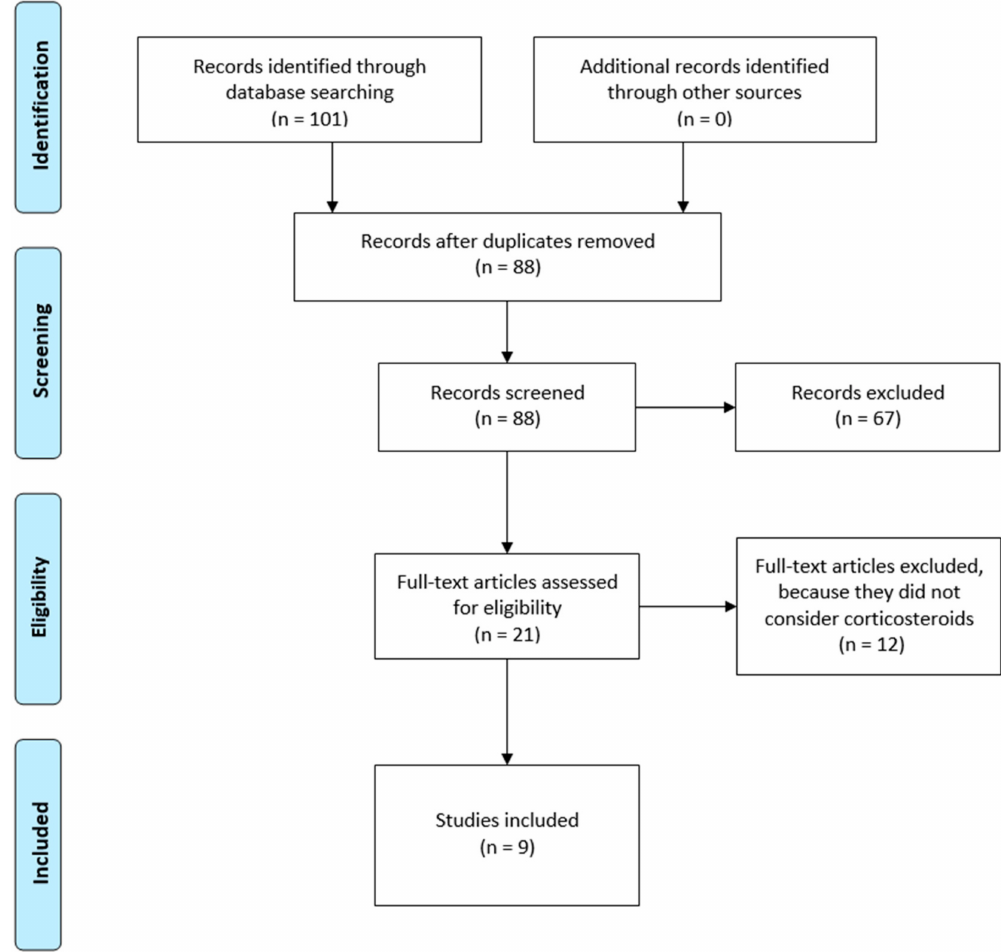
Figure 1. PRISMA (preferred reporting items of systematic reviews) flow diagram of study inclusion